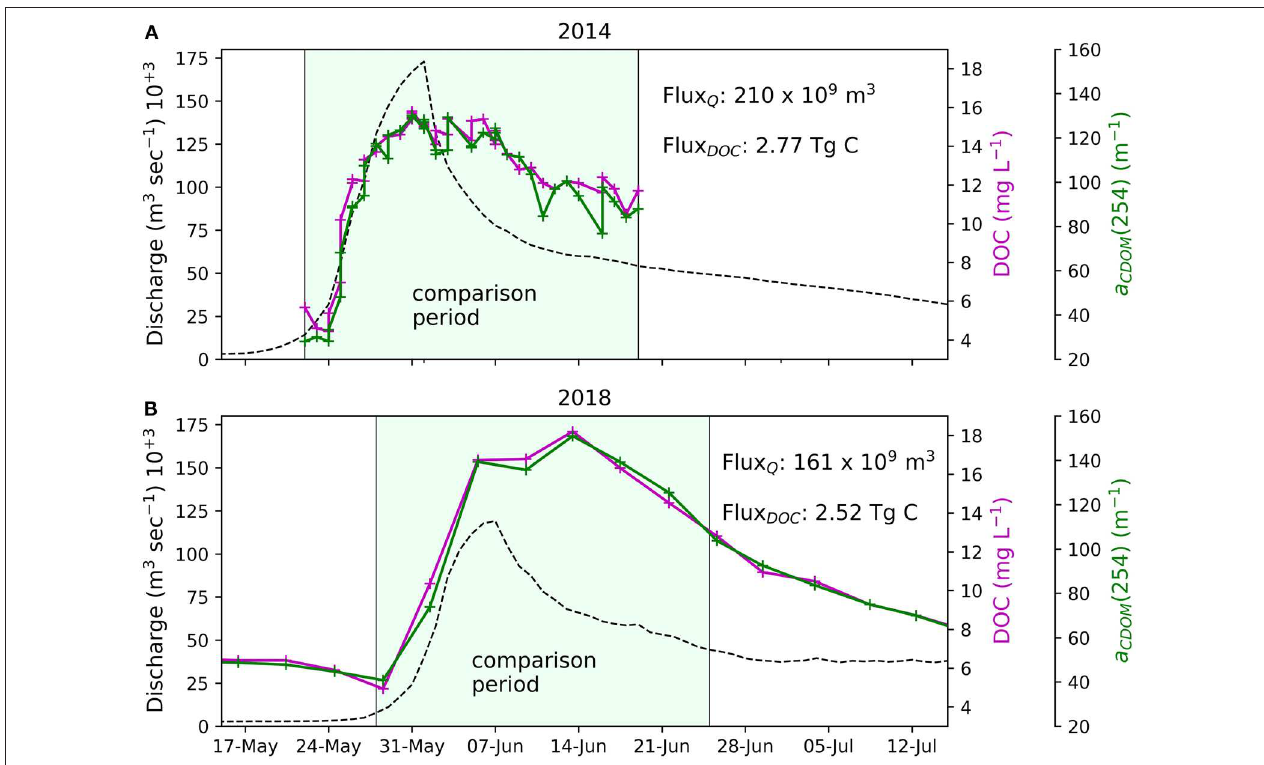
FIGURE 7 | DOC and a CDOM (254) concentrations in 2014 (A) and 2018 (B) . The 2014 sampling period, was compared to the hydrologically same period in 2018. The flux of discharge (Q) and DOC for the period (29 days) is presented in each